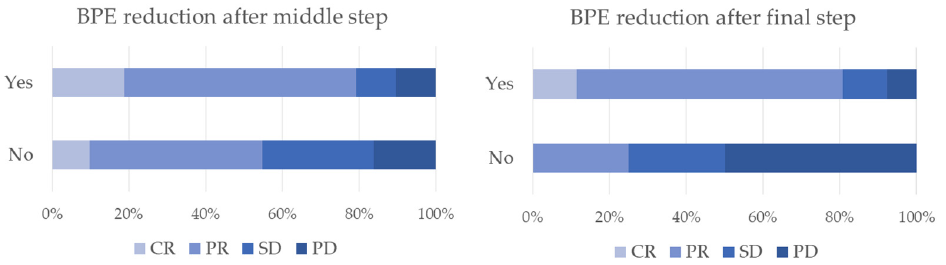
Figure 4. Distribution of BPE reduction after middle and final step respect to neoadjuvant chemotherapy (NAC). Table 9. Distribution of the response to the neoadjuvant therapy with respect to the dosing regimen of the neoadjuvant therapy performed.